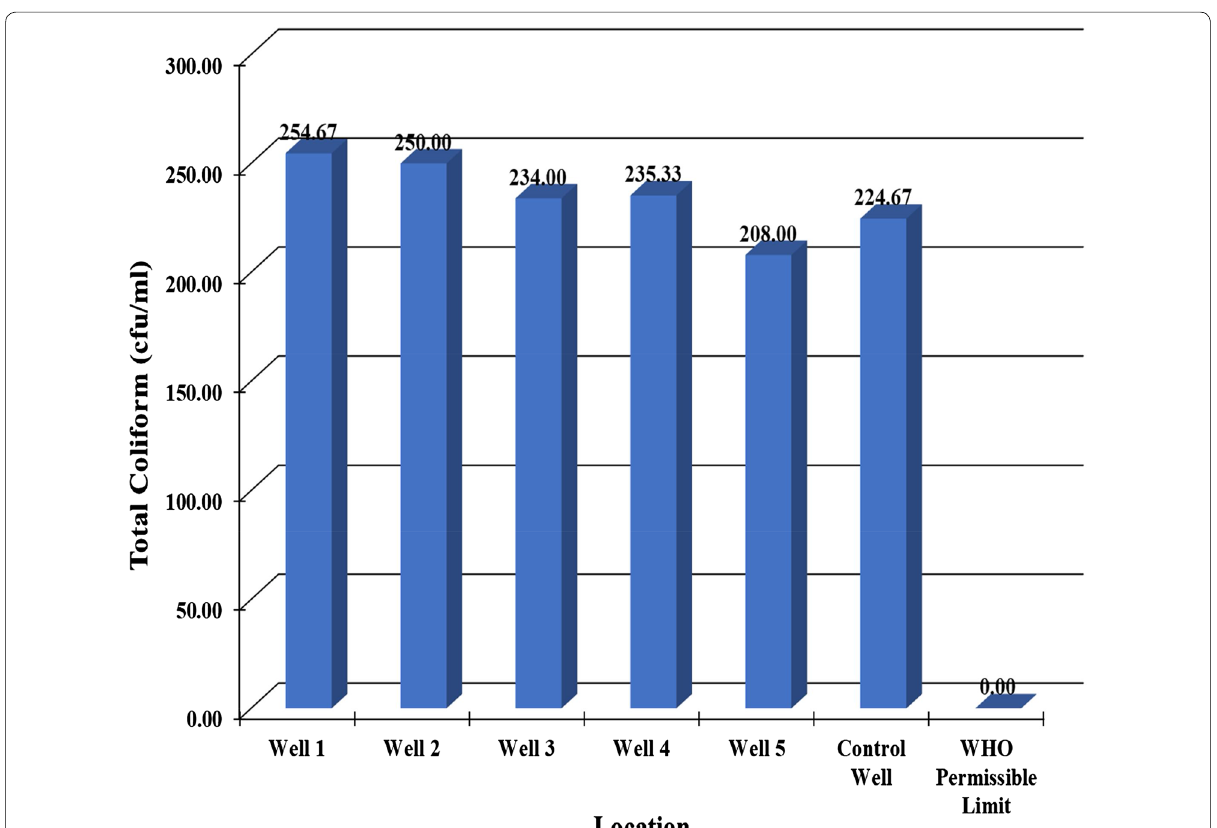
Fig. 2 Total fecal coliform of water samples collected from the sampling